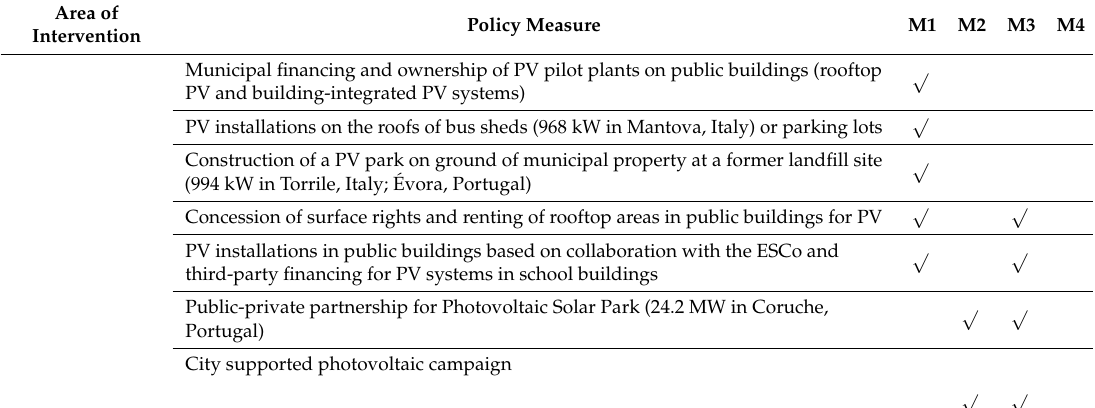
Table A1. Renewable energy